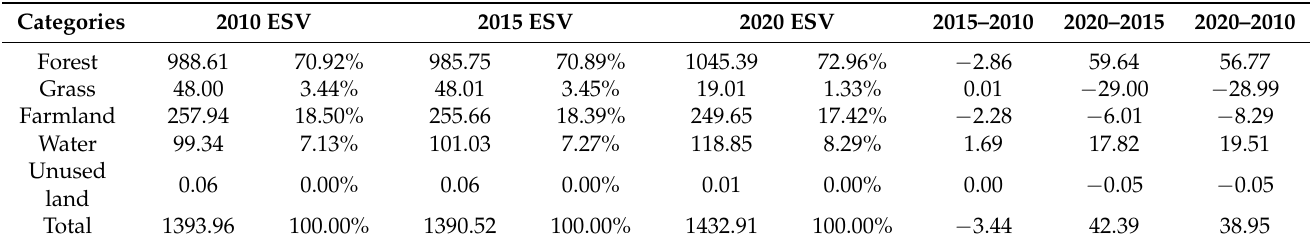
Figure 3. Spatial distribution of ecosystem service value (ESV) in Dabie Mountains for the years ( a ) 2010, ( b ) 2015, and ( c ) 2020. The ESV of vegetation cover types and the difference between the years in the study area were counted. The statistical results are shown in Table 2. The total ESV of the study area in 2010, 2015, and 2020 is CNY 139.396 billion, 139.052 billion, and 143.291 billion, respectively. Overall, the proportion of forest land ESV is the largest in the study area, which is about CNY 100 billion during this period. The second is farmland ecosystem, with an ESV of about CNY 25 billion during this period. The water ecosystem ESV has increased year by year, from CNY 9.934 billion in 2010 to CNY 11.885 billion in 2020. Table 2. Ecosystem service value and its change according to land cover types in the study area (10 8 CNY/ha·a).